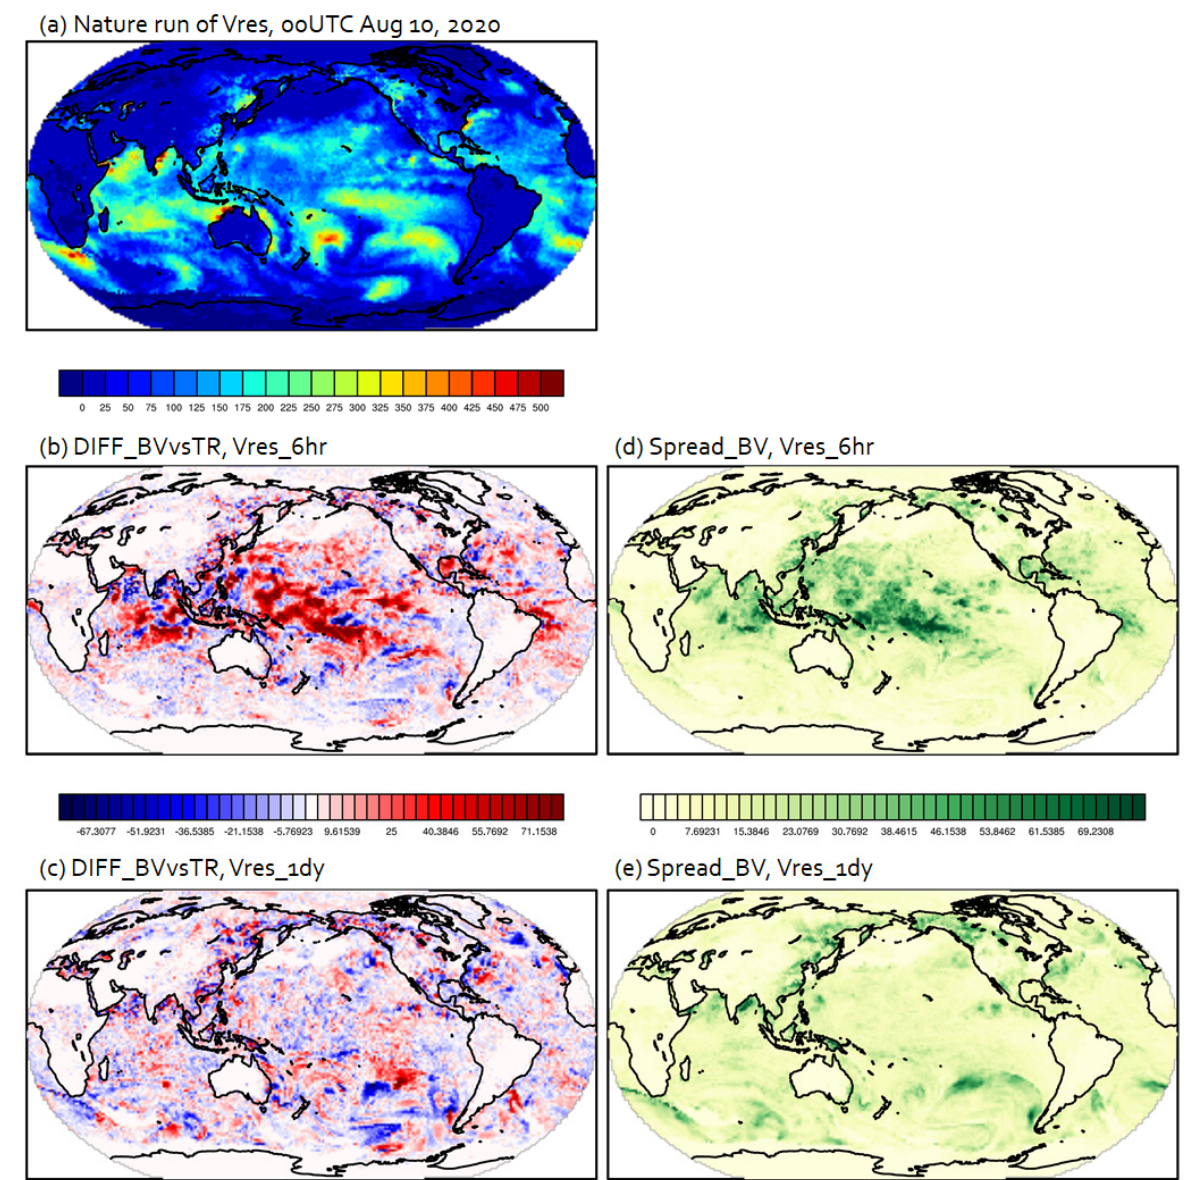
Figure 3. The same as Figure 2, but from the Vres experiments.